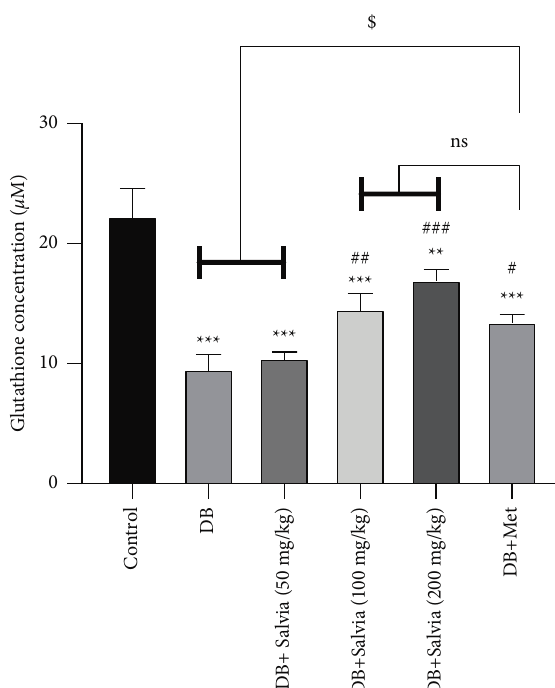
Figure 9: Effect of Salvia spinosa extracts on mitochondrial glutathione in renal isolated mitochondria in streptozotocin-induced diabetic mice. Control: normal mice, DB: diabetic mice, DB +Salvia: diabetic mice given the methanolic extract of Salvia spinosa , and DB +Met: diabetic mice given metformin (500 mg/kg). Values represented as mean ± SD. ∗∗ P < 0 . 01 compared with control mice. ∗∗∗ P < 0 . 001 compared with control mice. # P < 0 . 05 compared with diabetic mice. ## P < 0 . 01 compared with diabetic mice. ### P < 0 . 001 compared with diabetic mice. $ P < 0 . 05 compared with metformin-treated diabetic mice. Ns: nonsignificant.